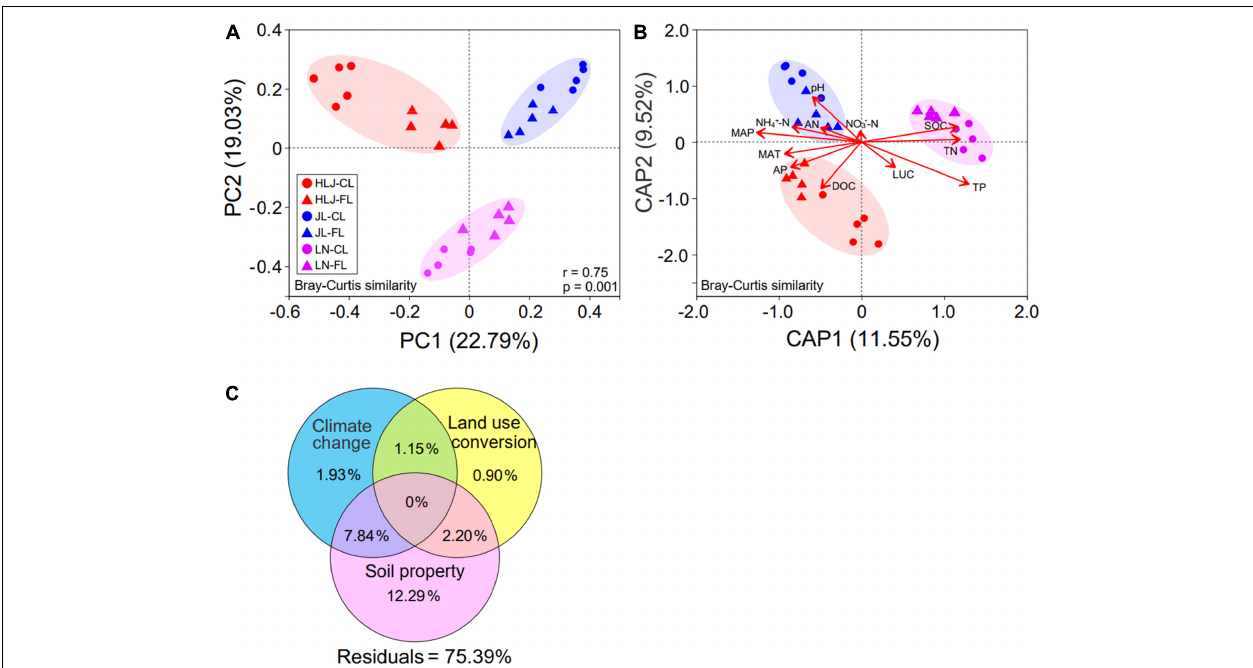
FIGURE 2 | AMF community structure and influencing factors. (A) Principal coordinate analysis (PCoA) of AMF community structure (Bray–Curtis dissimilarity) under climate change and land-use conversion. The ellipses represent standard deviations; (B) distance-based redundancy analysis (db-RDA) of AMF community structure (Bray–Curtis dissimilarity) in response to CC, LUC and soil properties. Variables and environmental vector correlation plots show the directions and strengths of the relationships between two environmental factors. Axis legends represent the percentage of variation explained by the axis; and (C) variation partitioning analysis (VPA) of the effects of climatic climate, LUC, and soil properties on AMF community structure. CL, cropland; FL, fallow land; MAT, mean annual temperature; MAP, mean annual precipitation; DOC, dissolved organic carbon; SOC, soil organic carbon; AN, available nitrogen; AP, available phosphorus; TP, total phosphorus; TN, total nitrogen. NO 3 - -N, nitrate nitrogen; NH 4 + -N, ammonium